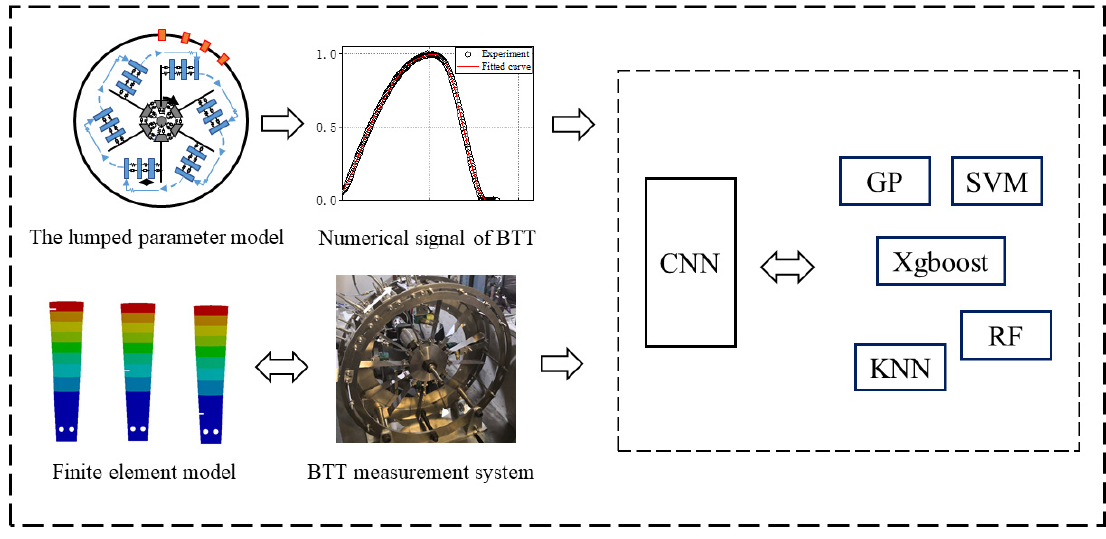
Figure 1. The complete closed block diagram.